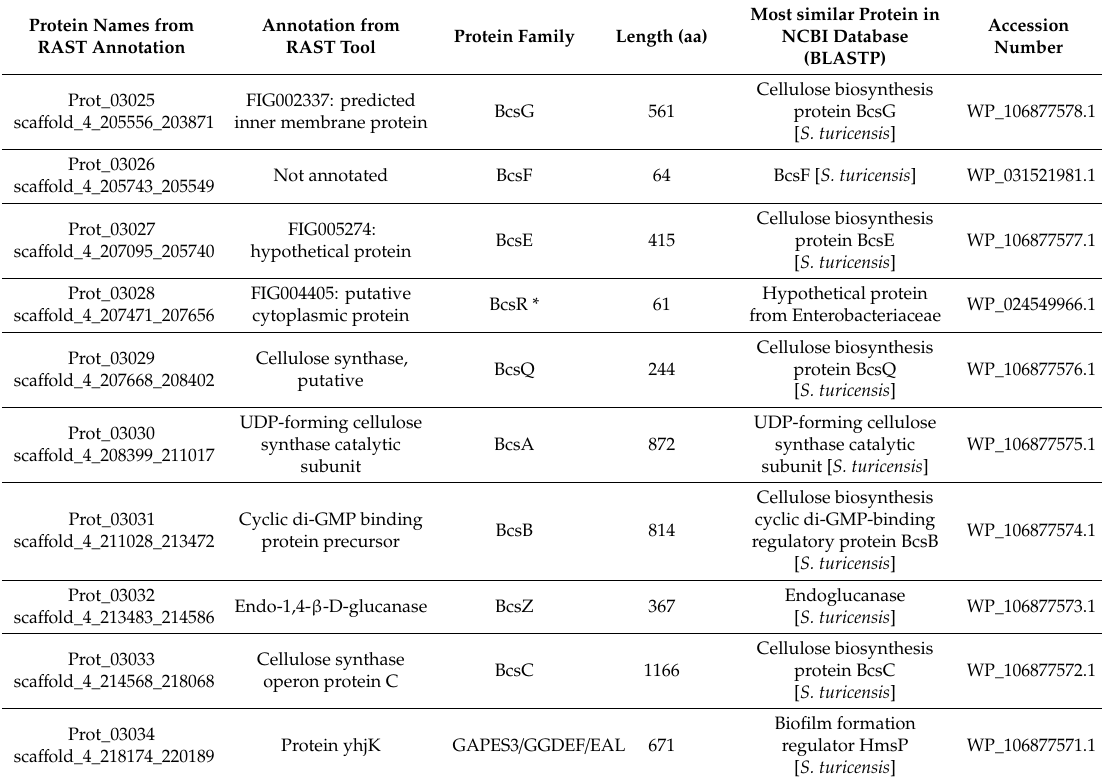
Table 3. Predicted proteins of cellulose metabolism identified from the #493 genome sequences (annotated using RAST, Pfam, and BLAST).